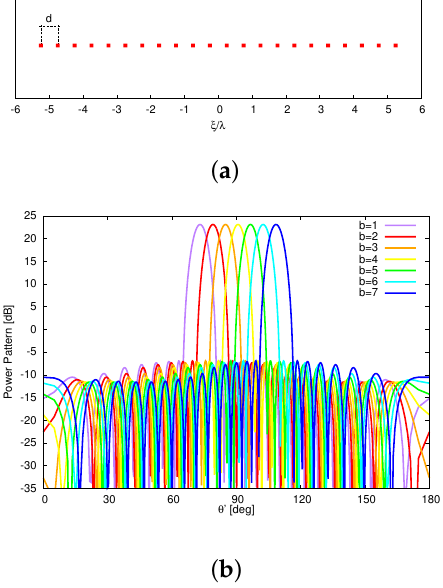
Figure 5. Numerical Assessment ( I = 22, d = λ the FP reference linear array and of ( b ) the B radiated (reference) power